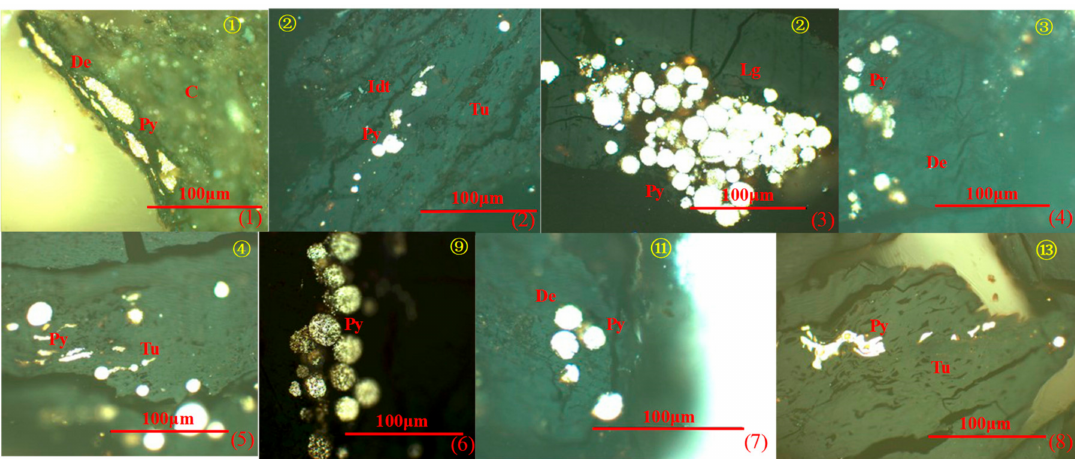
Figure 9. Occurrence of pyrite in different coal samples (the number in the yellow circle is the sample number, and the number in the red parenthesis is a series number of the photo; ( 1 ) vein pyrite, filled in desinite (De) surrounded by clay; ( 2 ) framboidal pyrite, distributed in texto-ulminite (Tu); ( 3 ) framboidal pyrite, distributed in groups around levigelinite (Lg) and texto-ulminite (Tu); ( 4 ) framboidal pyrite, distributed in desinite (De); ( 5 ) framboidal and vein pyrites distributed in texto-ulminite (Tu); ( 6 ) framboidal pyrite, distributed in groups in texto-ulminite (Tu); ( 7 ) framboidal pyrite, distributed in desinite (De); and ( 8 ) xenomorphic pyrite, filled in the cell of texto-ulminite